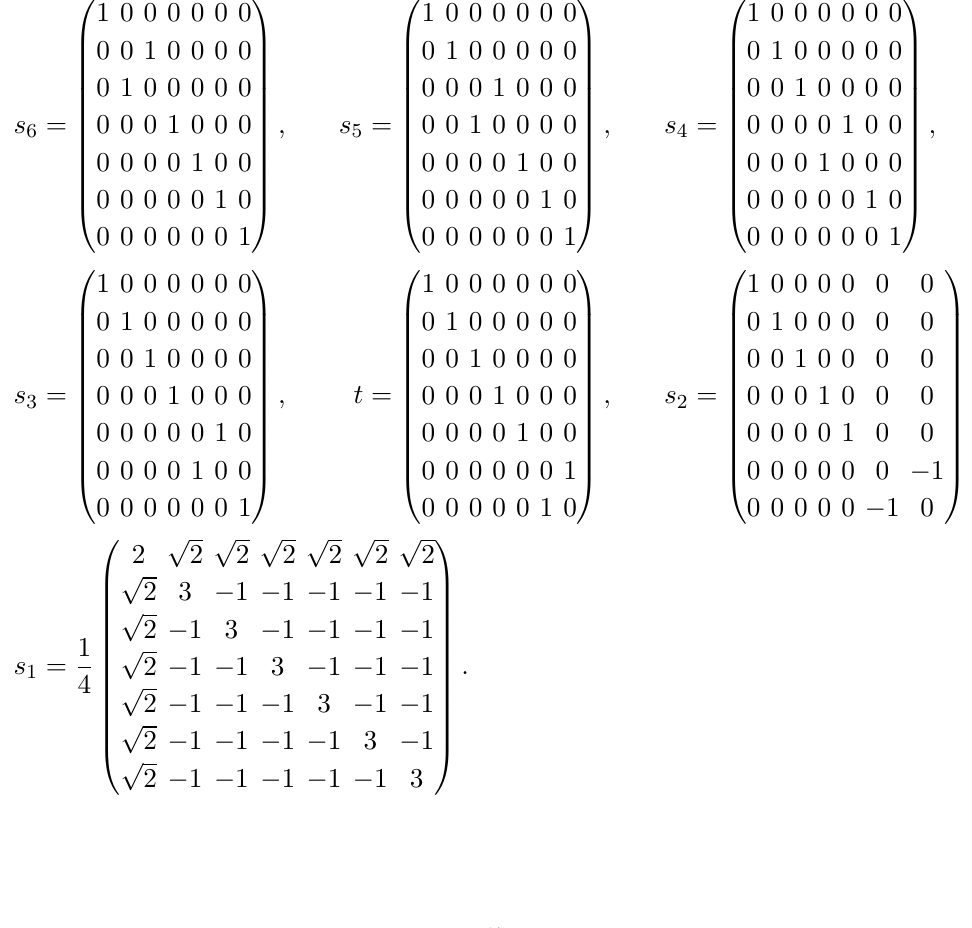
commuting. Spanning the space C 7 with the coordinates z sented by the transformations of the z